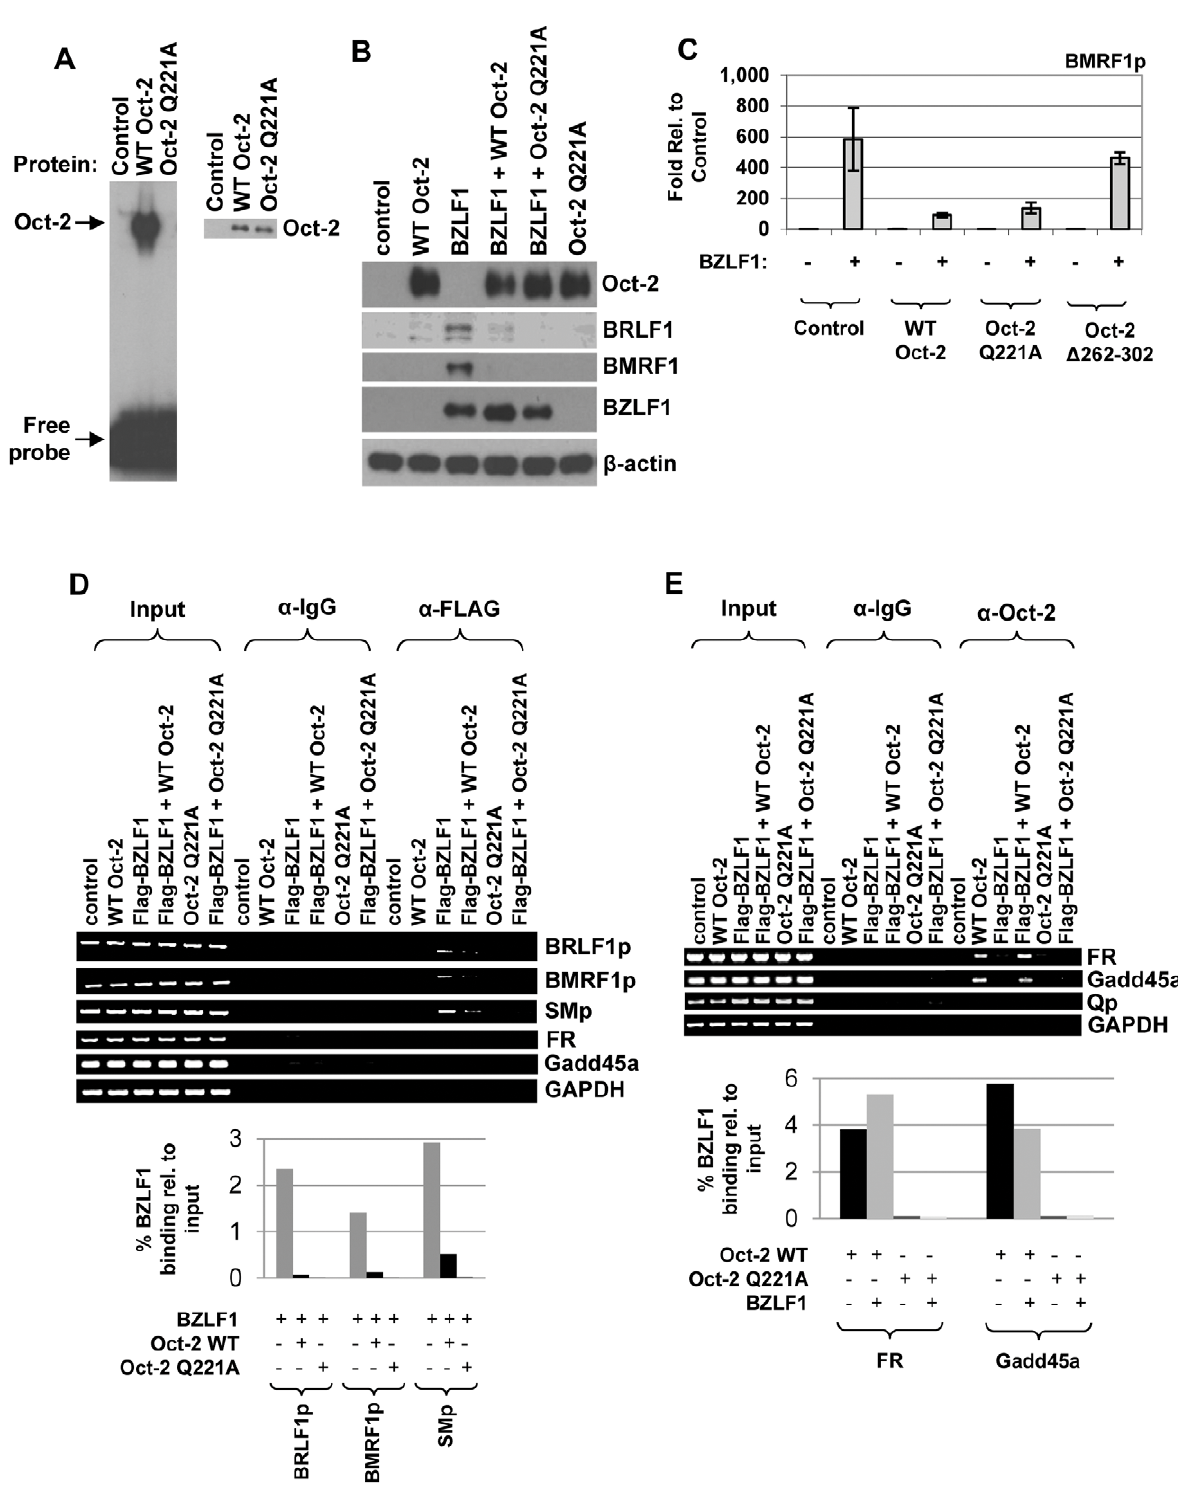
Figure 7. Oct-2 DNA-binding activity is not required for Oct-2 inhibition of BZLF1 function. (A) (Left panel) An EMSA was performed using in vitro -translated wild-type or mutant Oct-2 (Q221A) protein and a 32 P-labelled oligonucleotide probe containing the consensus Oct-2 binding site. Protein-DNA complexes are indicated by arrows. (Right panel) Immunoblot analysis was performed to compare the levels of wild-type and mutant Oct-2 (Q221A) in the in vitro -translated samples. (B) HONE-Akata cells were transfected with 5 ng BZLF1, 500 ng wild-type Oct-2, 500 ng mutant Oct-2 (Q221A), or control vectors as indicated. Immunoblot analysis was performed two days after transfection to compare levels of transfected BZLF1 and Oct-2, as well as the levels of BMRF1 and BRLF1 protein derived from the endogenous viral genome. b -actin served as a loading control. (C) EBV-negative BJAB cells were transfected with a BMRF1p-luciferase construct in the presence or absence of co-transfected BZLF1 (30 ng), wild-type Oct-2 (1470 ng), two different mutant Oct-2 proteins (Oct-2 Q221A or Oct-2 D 262–302) (1470 ng), or control vectors as indicated.